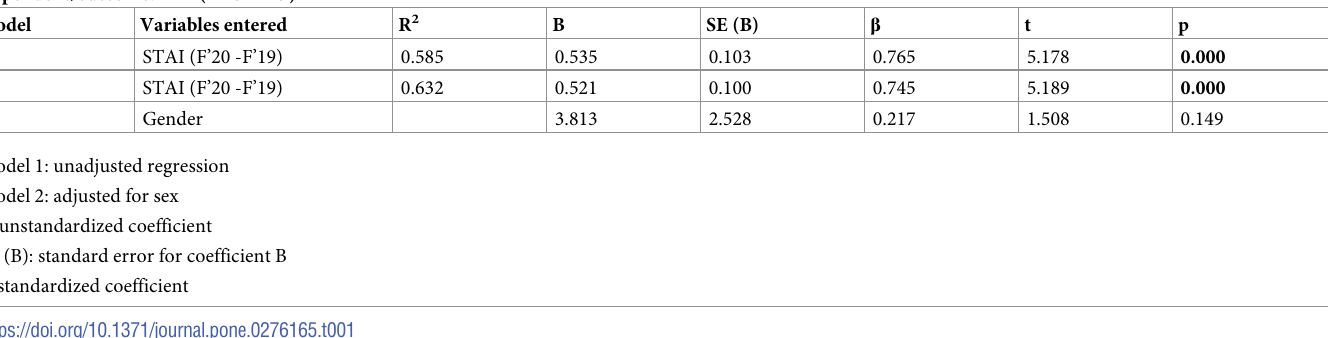
Table 1. Regression analysis of differences between mid- and pre-pandemic depression symptoms (BDI) (as outcome) and anxiety (STAI). Dependent/outcome: BDI (F’20